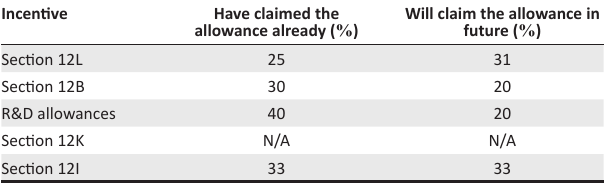
TABLE 3: Importance of availability of tax